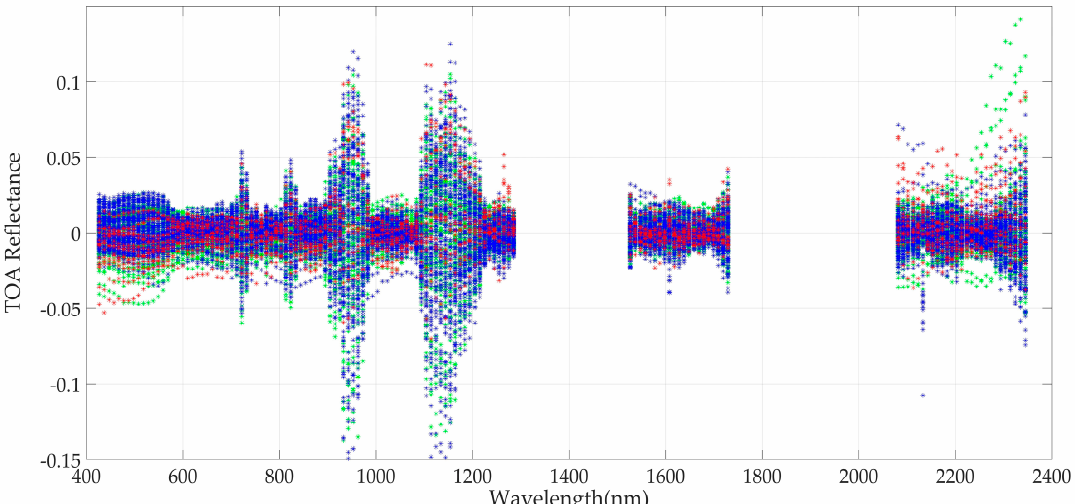
Figure 9. Absolute difference between the individual normalized hyperspectral data with the mean Cluster 13 hyperspectral data.